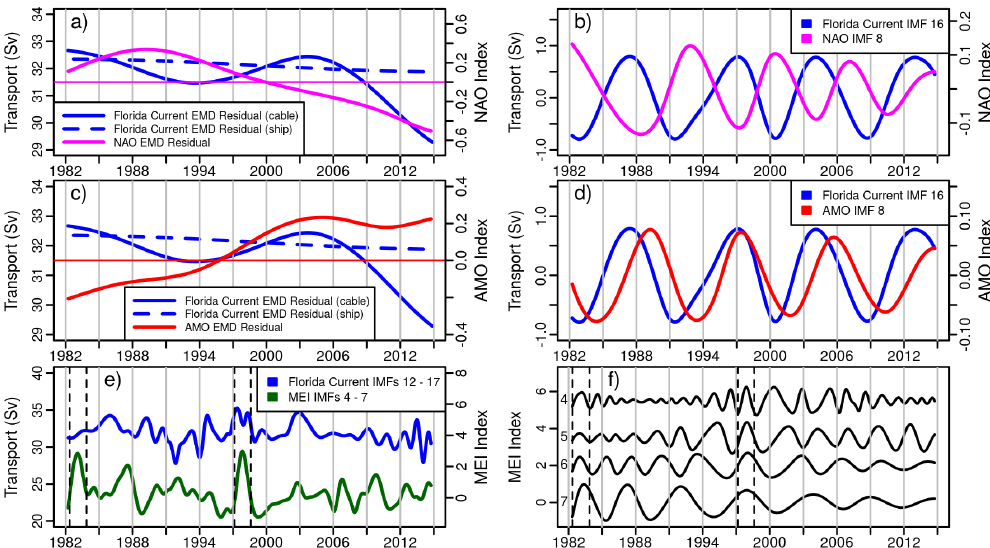
Figure 3. Comparison of Florida Current IMFs with the NAO, AMO, and MEI indices. (a) Florida Current and NAO index EMD residuals. (b) Decadal-scale IMFs of Florida Current ( N IMF = 17) and NAO index ( N IMF = 10). (c) Florida Current and AMO index EMD residuals. (d) Decadal-scale IMFs of Florida Current and AMO index ( N IMF = 9). (e) Sum of Florida Current IMFs 12–17 (blue) and sum of MEI IMFs 4–7 (green; N IMF = 9). (f) MEI IMFs 4–7. IMFs are vertically offset for clarity. The dashed vertical lines in ( e and f ) bracket